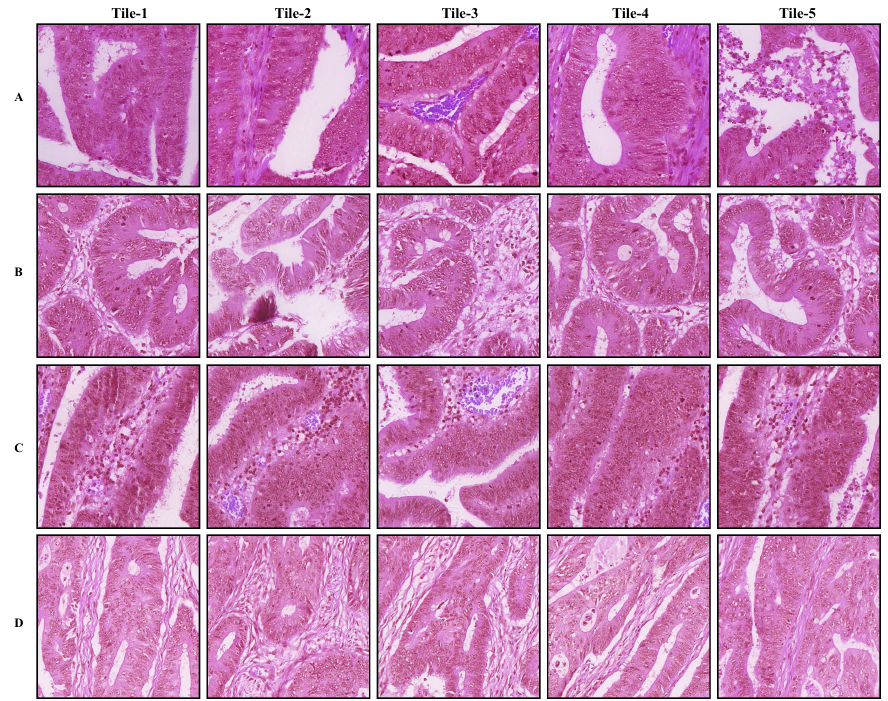
Figure 5. Representative tiles of tumor classification using 10 × tiles of the whole slide images (WSIs). The ( A – D ) samples are randomly selected from the testing set. In each row, tiles 1–5 are patches from the same